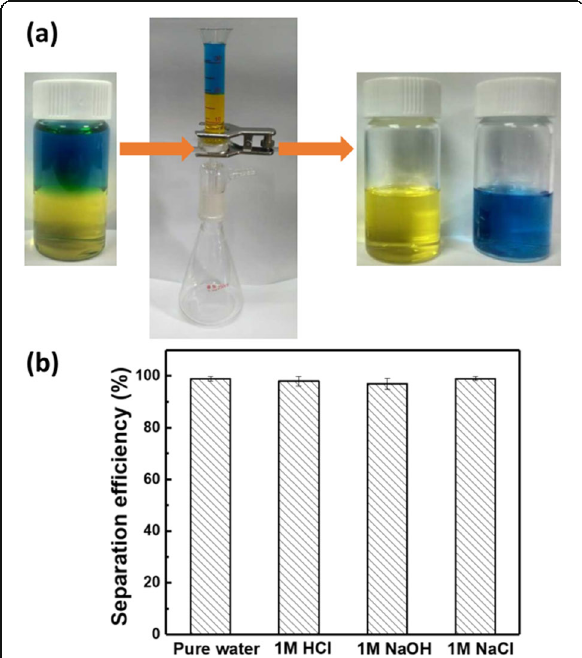
Fig. 6 a Oil/water separation device and process, b separation efficiencies for immiscible oil/water mixtures containing different water phase by the modified F-60